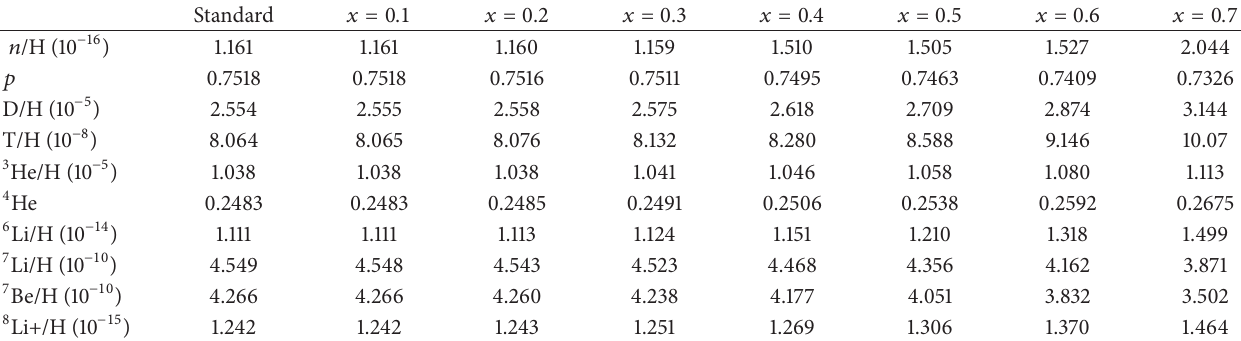
Table 1: Elements produced in the ordinary sector. The last row includes all elements with atomic mass larger than 7.